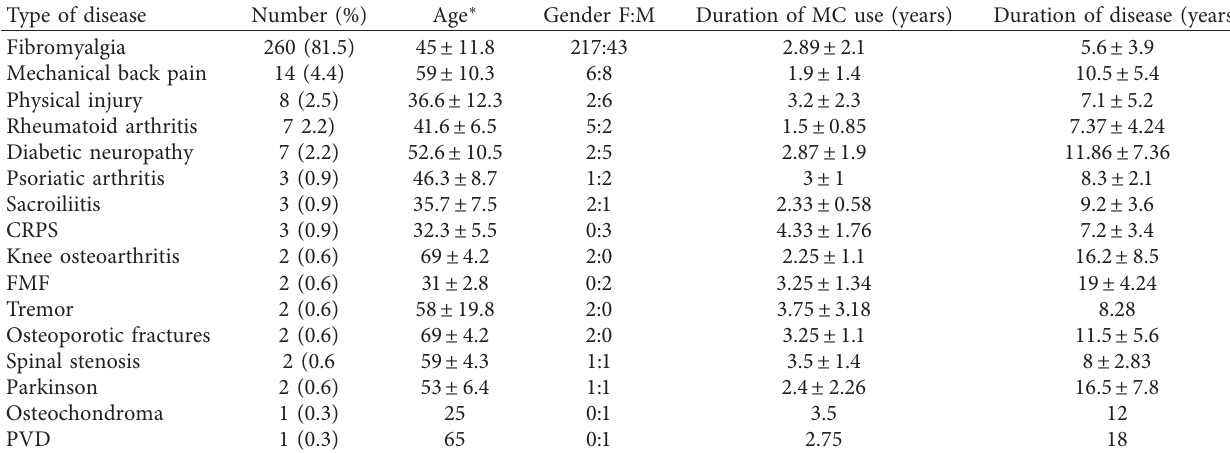
Table 1: Rheumatologic diagnoses and demographic characteristics of 319 patients receiving medical cannabis different rheumatology outpatient clinics in North of Israel.